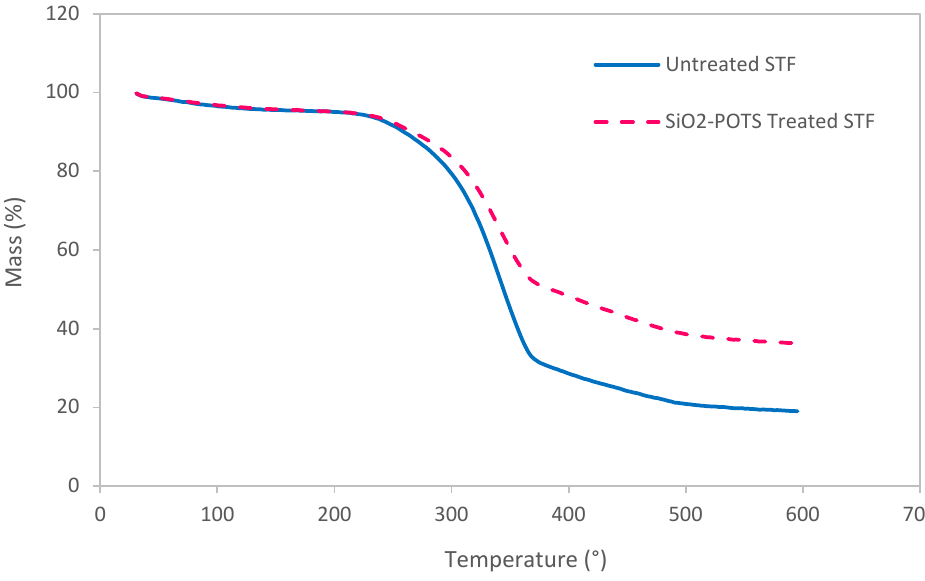
Figure 5. Thermogram of untreated and SiO 2 -PFOTS treated ST.